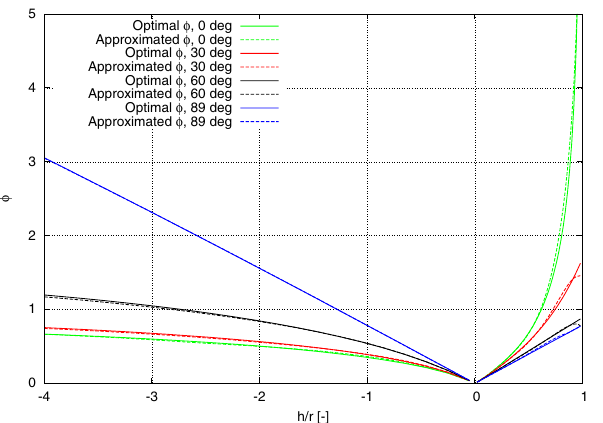
Figure 2. Approximation of (cid:56) at different helix angles compared to the optimal (cid:56) value.